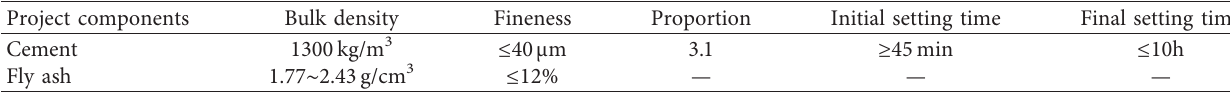
Table 3: The physical properties of cement and fly ash.